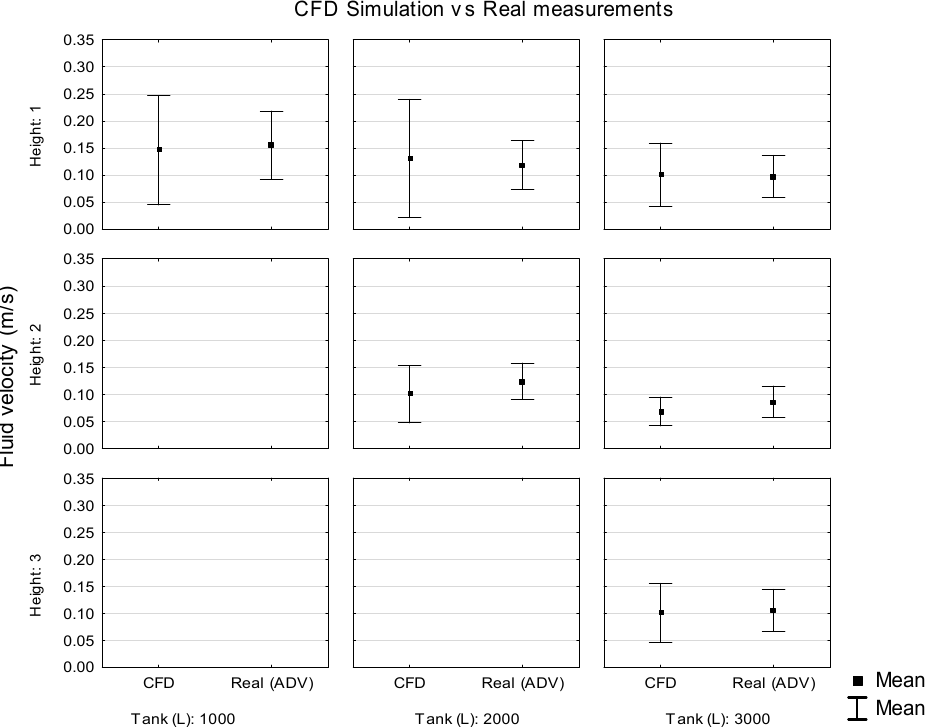
Figure 9. Mean fluid velocities, estimated by CFD and experimentally measured, according to the height of the measurement point (1: 0.37 m; 2: 0.65 m, 3: 0.93 m).